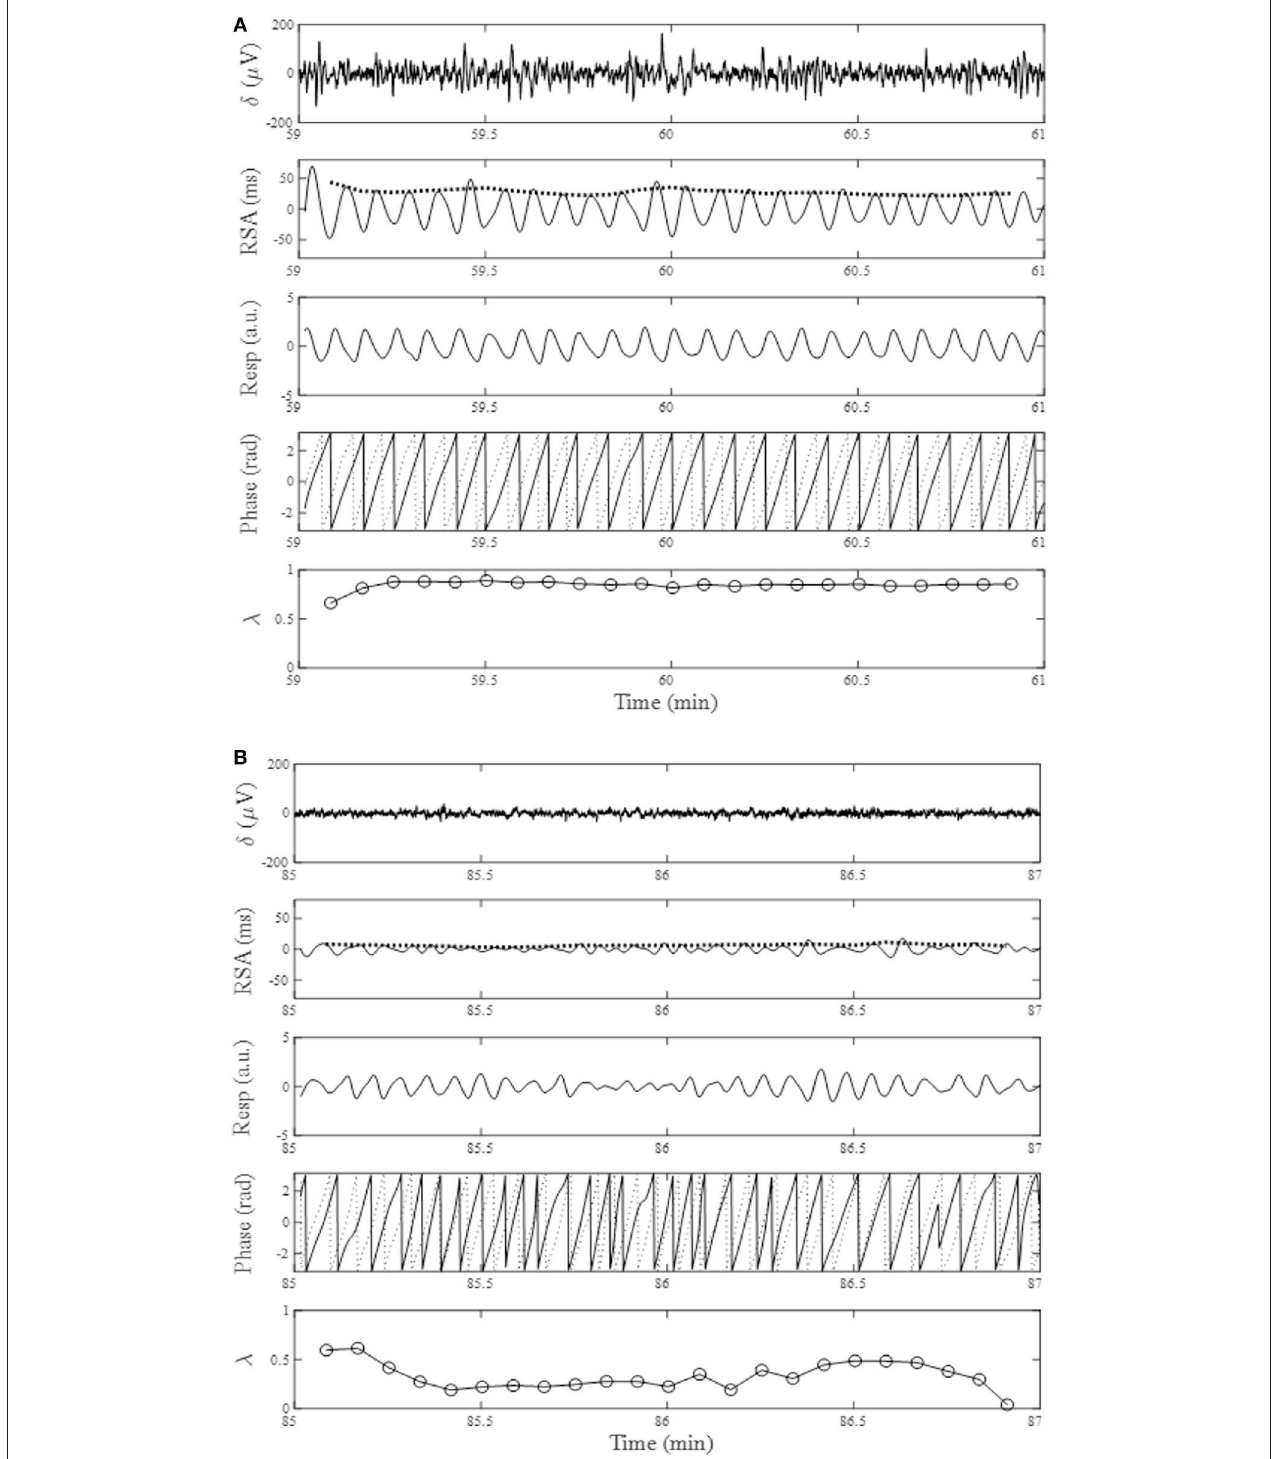
FIGURE 3 | From the top, changes in EEG δ -activity ( δ ), RSA, breathing trace (Resp in arbitrary unit; upward deflections denote expiration), instantaneous phases for RSA (solid trace) and breathing (dotted trace), and phase coherence ( λ ) calculated from 20-s windows with a sliding window of 10-s for a 2-min portion around increased EEG δ -activity ( A , 59–61min) and decreased EEG δ -activity ( B , 85–87min). Bold dotted curve in the RSA panel indicates A RSA . Data presented are form the same subject shown in Figure 2 .